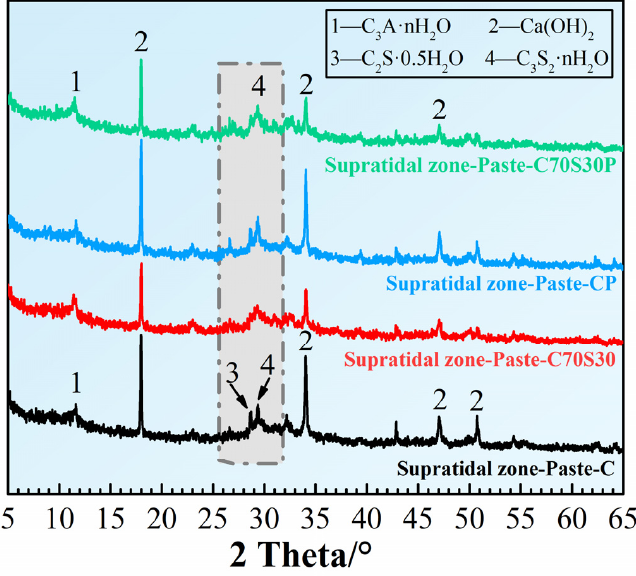
Figure 6. The XRD pattern of CBRM-Pastes servicing in the supratidal zone simulated environment at 28 + 180 days.